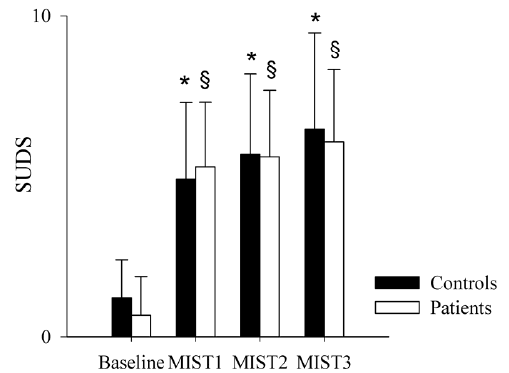
Figure 1. Comparison of the SUDS scale scores in healthy controls and PAH patients during the experimental sessions. The bar graphs show the Subjective Units of Distress Scale (SUDS) scores in healthy controls (black bars) and in PAH patients (white bars) at the end of the resting condition (Baseline) and after each of the three different blocks of the Montreal Imaging Stress Test (MIST1, MIST2 and MIST3). Results are presented as mean ± standard deviation. * indicates p < 0.05 vs. Baseline in the control group, and § indicates p < 0.05 vs. Baseline in the PAH patients’ group.